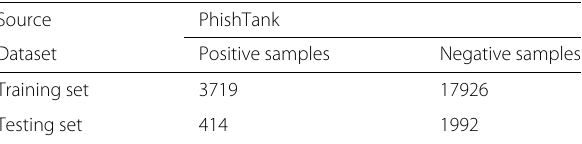
Table 3 Dataset for